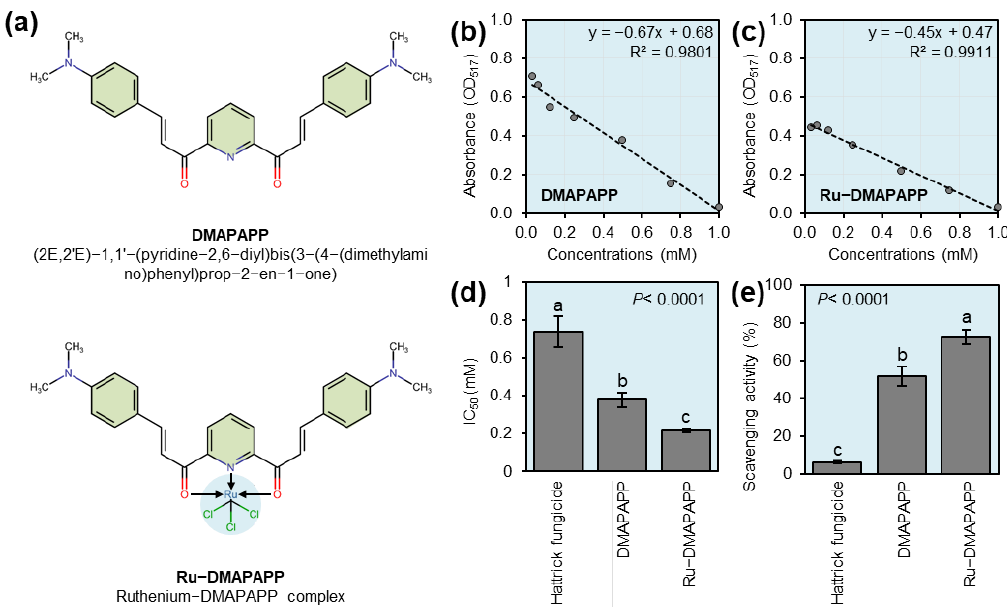
Figure 1. In vitro antioxidant activities of two bis-chalcone derivatives, DMAPAPP and its metal complex with ruthenium (Ru-DMAPAPP). ( a ) Chemical structures of DMAPAPP and Ru-DMAPAPP. ( b , c ) Standard curves of in vitro antioxidant activities using different concentrations (0.03, 0.06, 0.13, 0.25, 0.50, 0.75, and 1.00 mM) of DMAPAPP and Ru-DMAPAPP, respectively. ( d ) IC 50 and ( e ) scavenging activity (%) of DMAPAPP and Ru-DMAPAPP, respectively. Values represent the means ± standard deviations (means ± SD). Different letters indicate statistically significant differ- ences between treatments using the Tukey–Kramer honestly significant difference test (Tukey HSD; p <